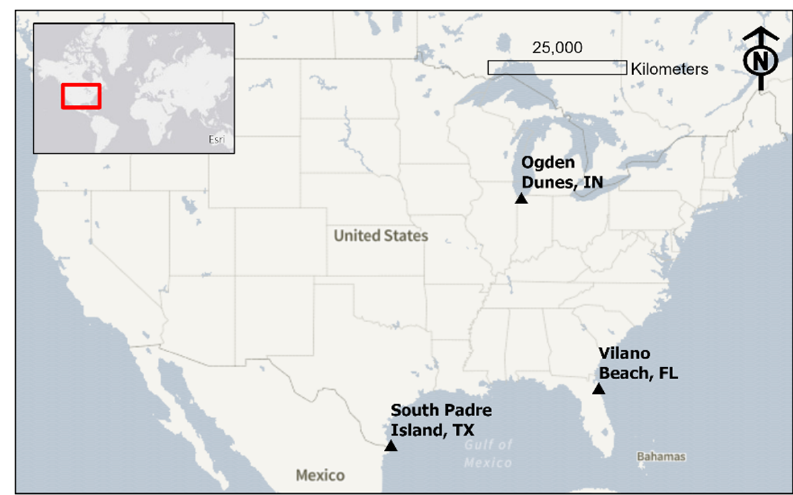
Figure 1. Site locations used in model set up.